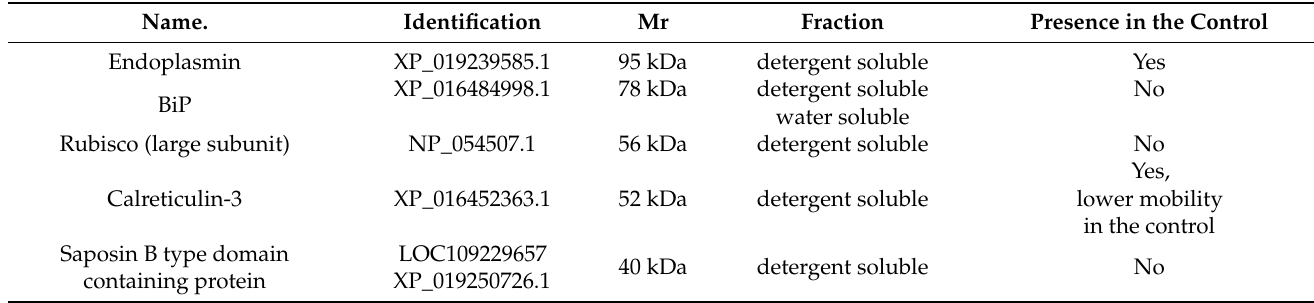
Table 1. Biotinylated proteins–candidate phytaspase interactors identified in this study.